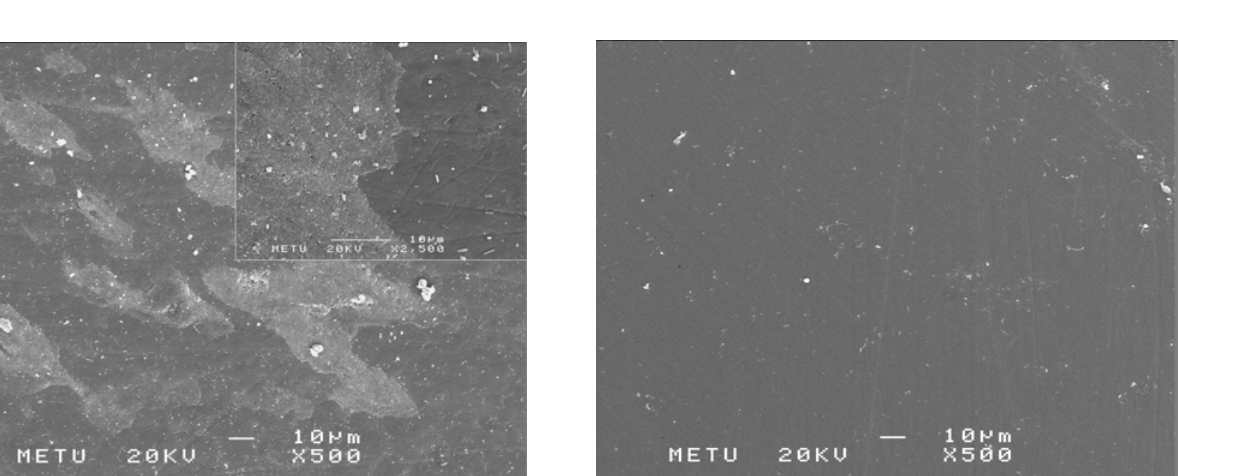
FIGURE 8- SEM analysis showing enamel surface after using 30-fluted tungsten carbide bur in combination with silicone carbide impregnated one-step OptiShine brush